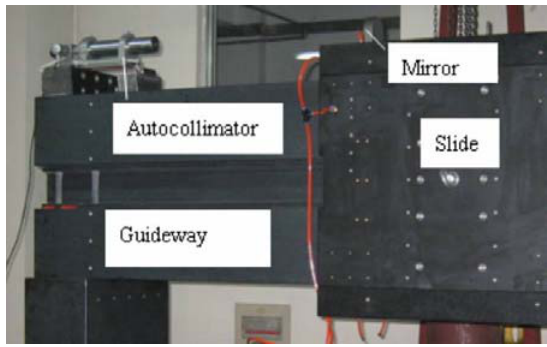
Figure 3. Experimental setup for measurement straightness of cross guideway.